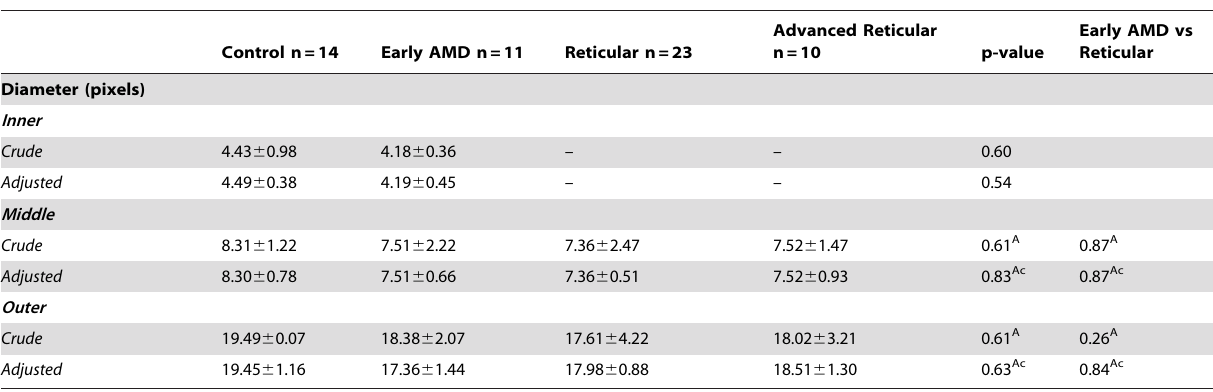
Table 4. Choroidal Vessel Diameter.